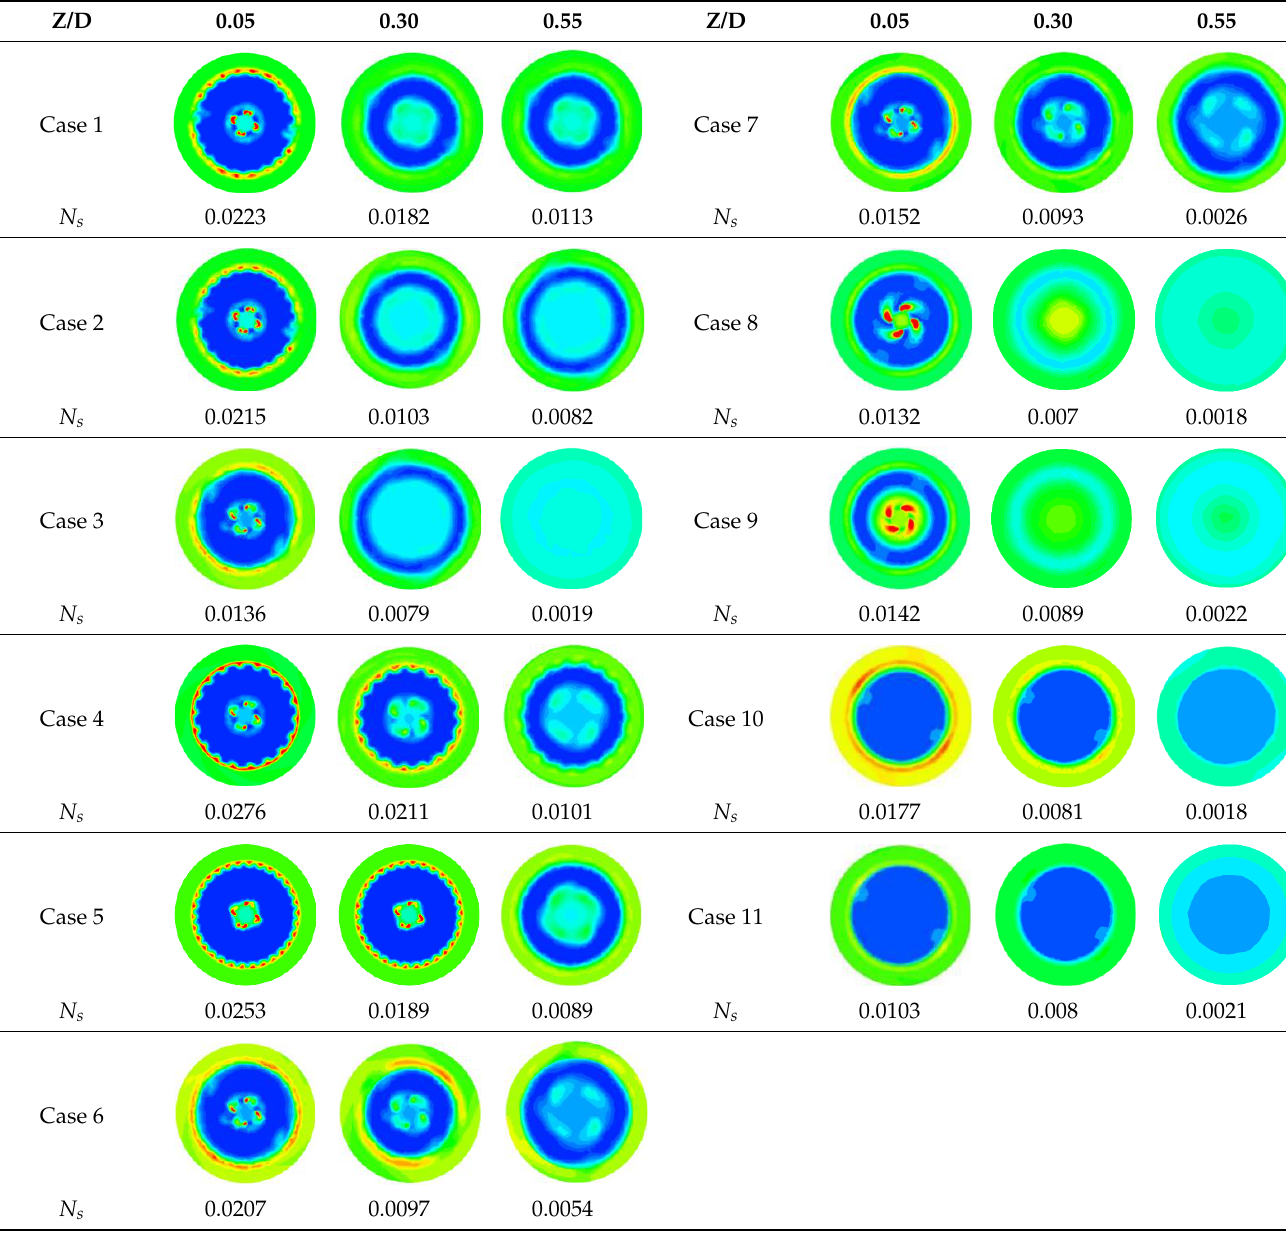
Table 3. The fuel/air mixing characteristics for different structures.